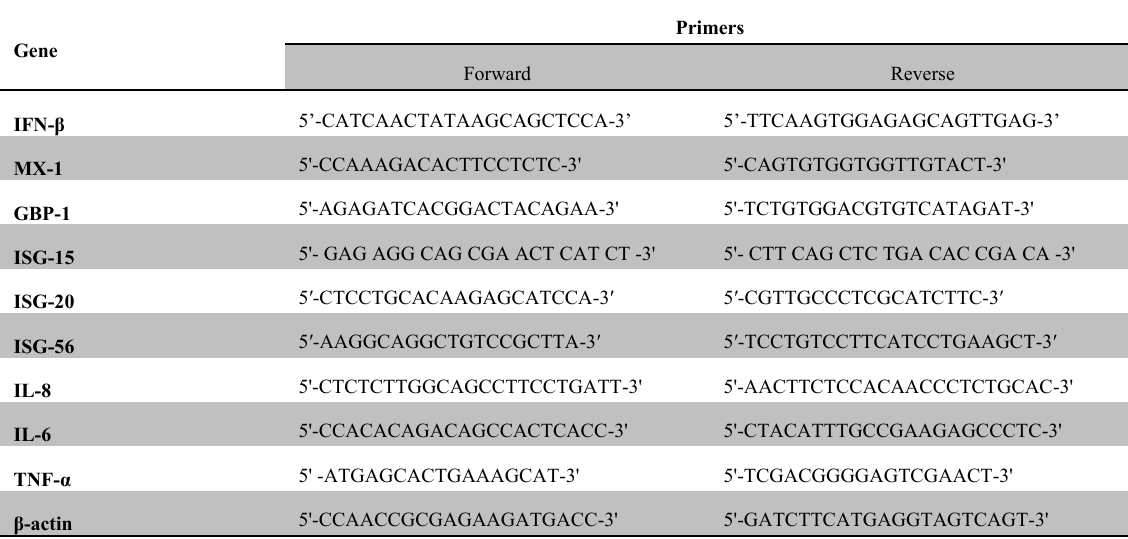
Table 3. Human primer sets used to confirm mRNA